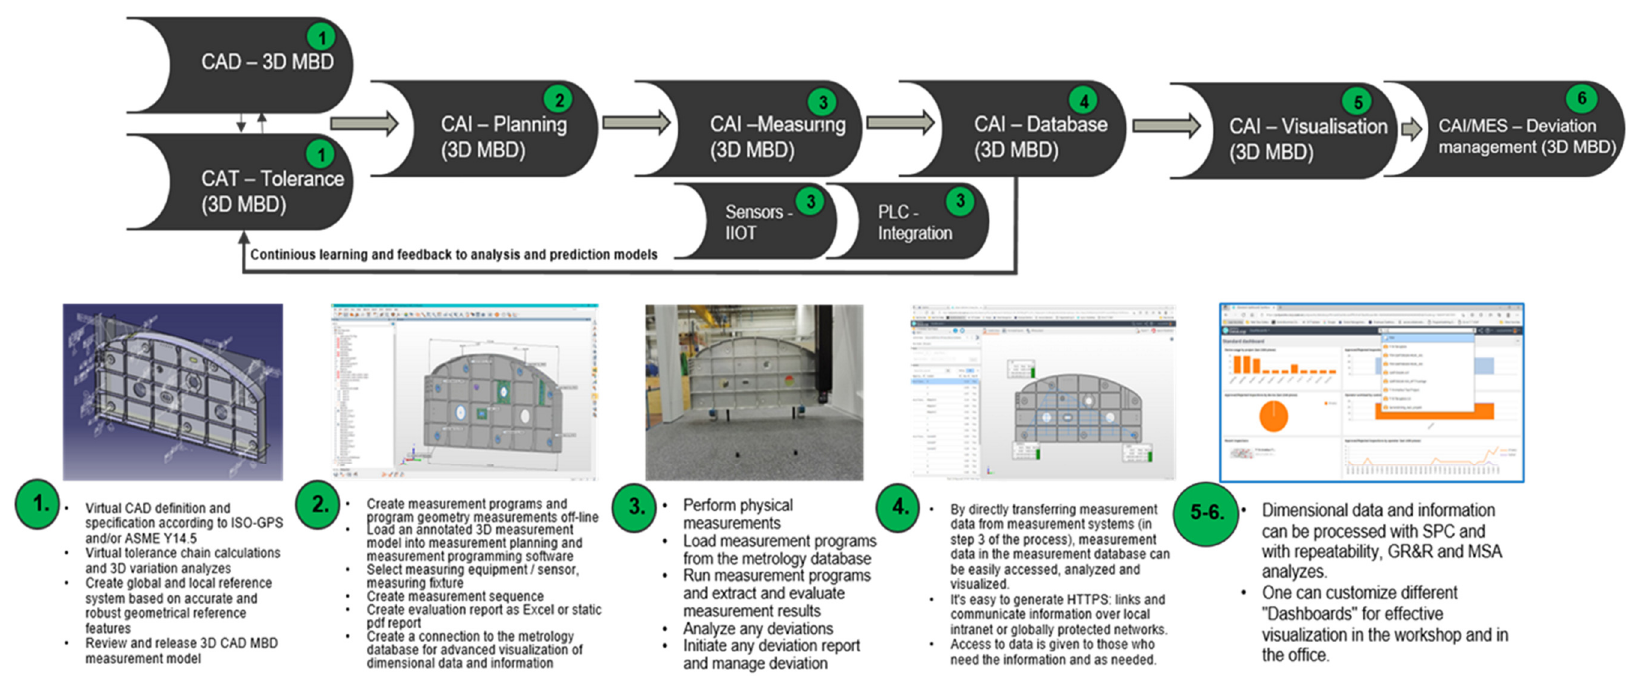
Figure 18. Generic digital thread and description of dimensional measurement activities. Presented and illustrated throughout the Product Lifecycle Management (e.g., CAD/CAI/MES) and Operational Technology domains (e.g., Sensor IIOTcontrol and PLC